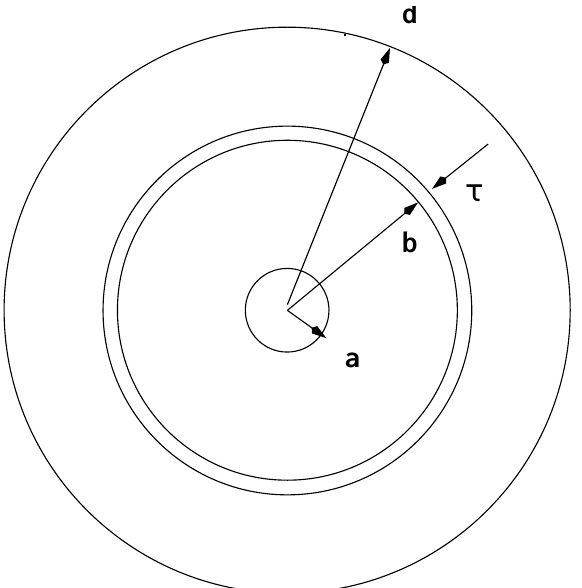
FIG. 1. Geometry of a screen in a circular cylindrical vacuum chamber.